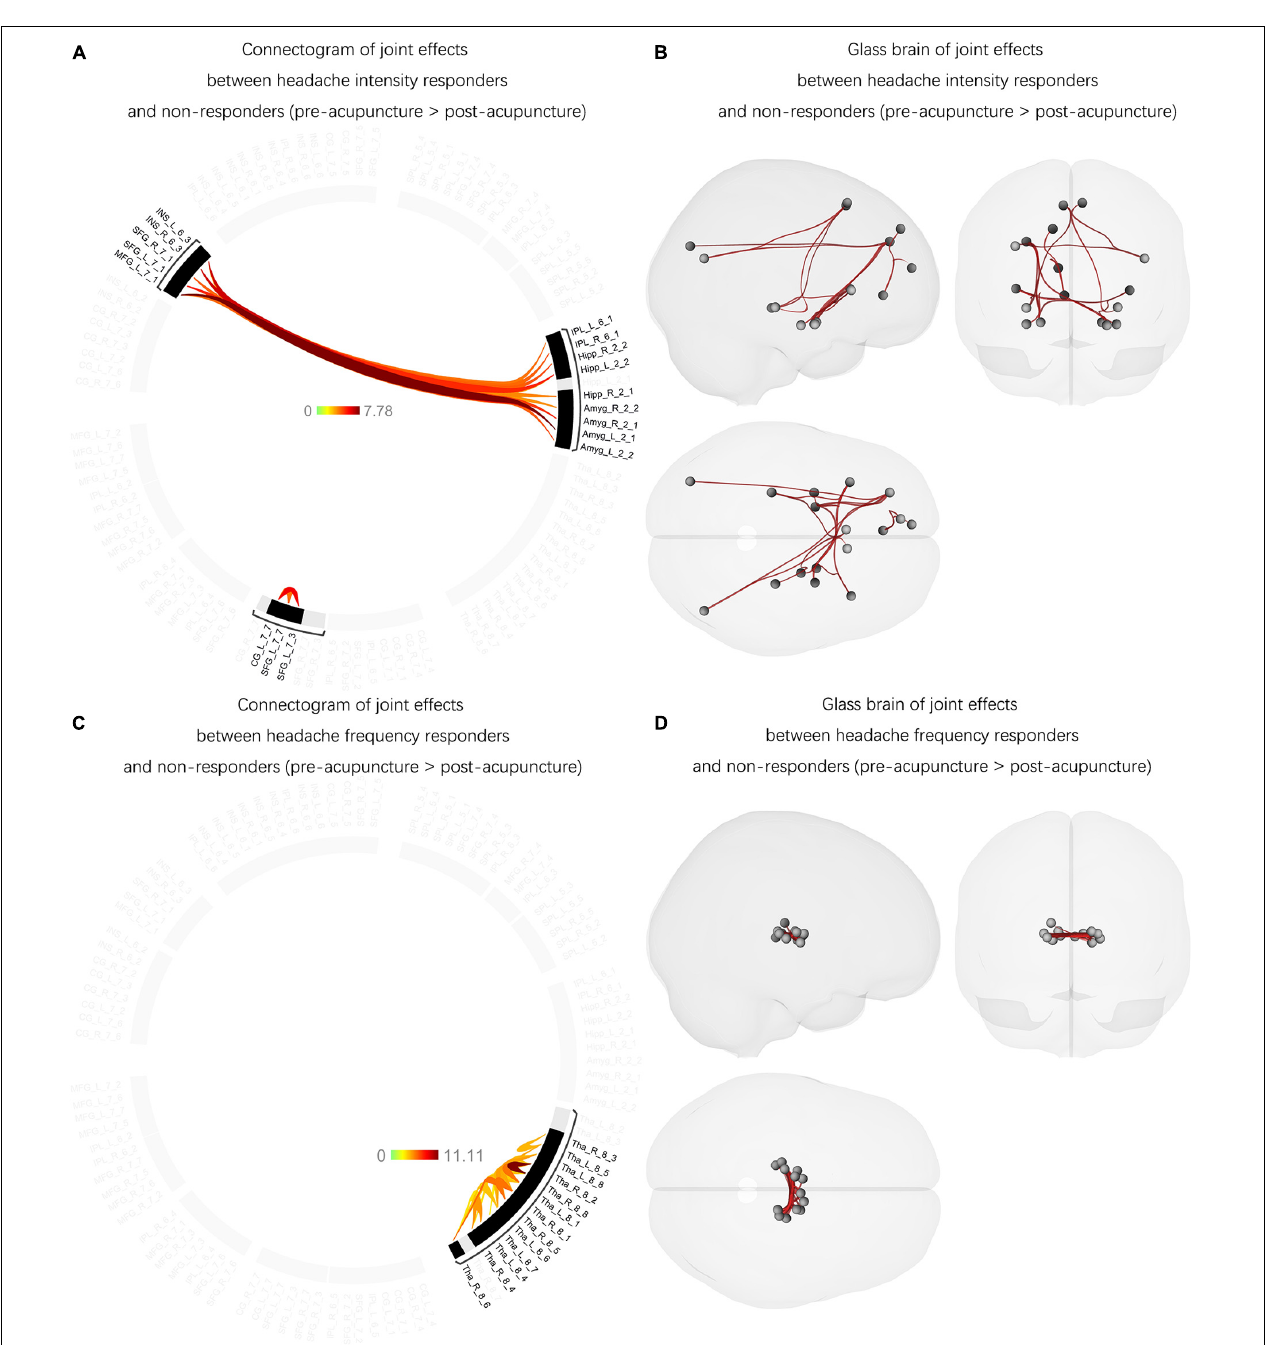
FIGURE 4 | The joint effects between the headache intensity responders, frequency responders, and non-responders (between pre- and post-acupuncture). (A) Significantly decreased and increased FCs were found between the headache intensity responders and non-responders compared with post-acupuncture, and the color bar represents the t -value of FC. (B) Headache intensity responders manifested significantly increased FCs between Amyg and MFG, Amyg and INS, IPL and SFG, IPL and MFG, Hipp and SFG, Hipp and MFG, Hipp and INS, and CG and SFG compared with posttreatment. Red connection lines represent an increased FC before acupuncture than post-acupuncture patients with MwoA. (C) Significantly decreased and increased FCs were found between the headache frequency responders and non-responders compared with post-acupuncture, and the color bar represents the t -value of FC. (D) Headache frequency responders showed significantly increased FC within Tha subregions compared with posttreatment. Red connection lines represent an increased FC before acupuncture than post-acupuncture patients with MwoA. MwoA, migraine without aura; responder, patient with significant clinical improvement; non-responder, patient with nonsignificant clinical improvement; FC, functional connectivity; L, left hemisphere; R, right hemisphere; SFG, superior frontal gyrus; MFG, middle frontal gyrus; SPL, superior parietal lobule; IPL, inferior parietal lobule; INS, insular gyrus; CG, cingulate gyrus; Amyg, amygdala; Hipp, hippocampus; Tha, thalamus.